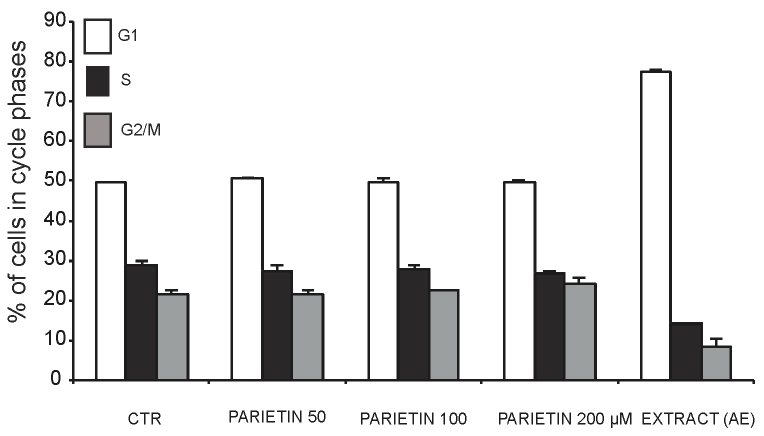
Figure 2. Cell cycle analysis in MDA-MB231 cells at 48 h after treatment with the Xanthoria parietina extract (1.5 mg/mL) or parietin at the indicated concentrations.